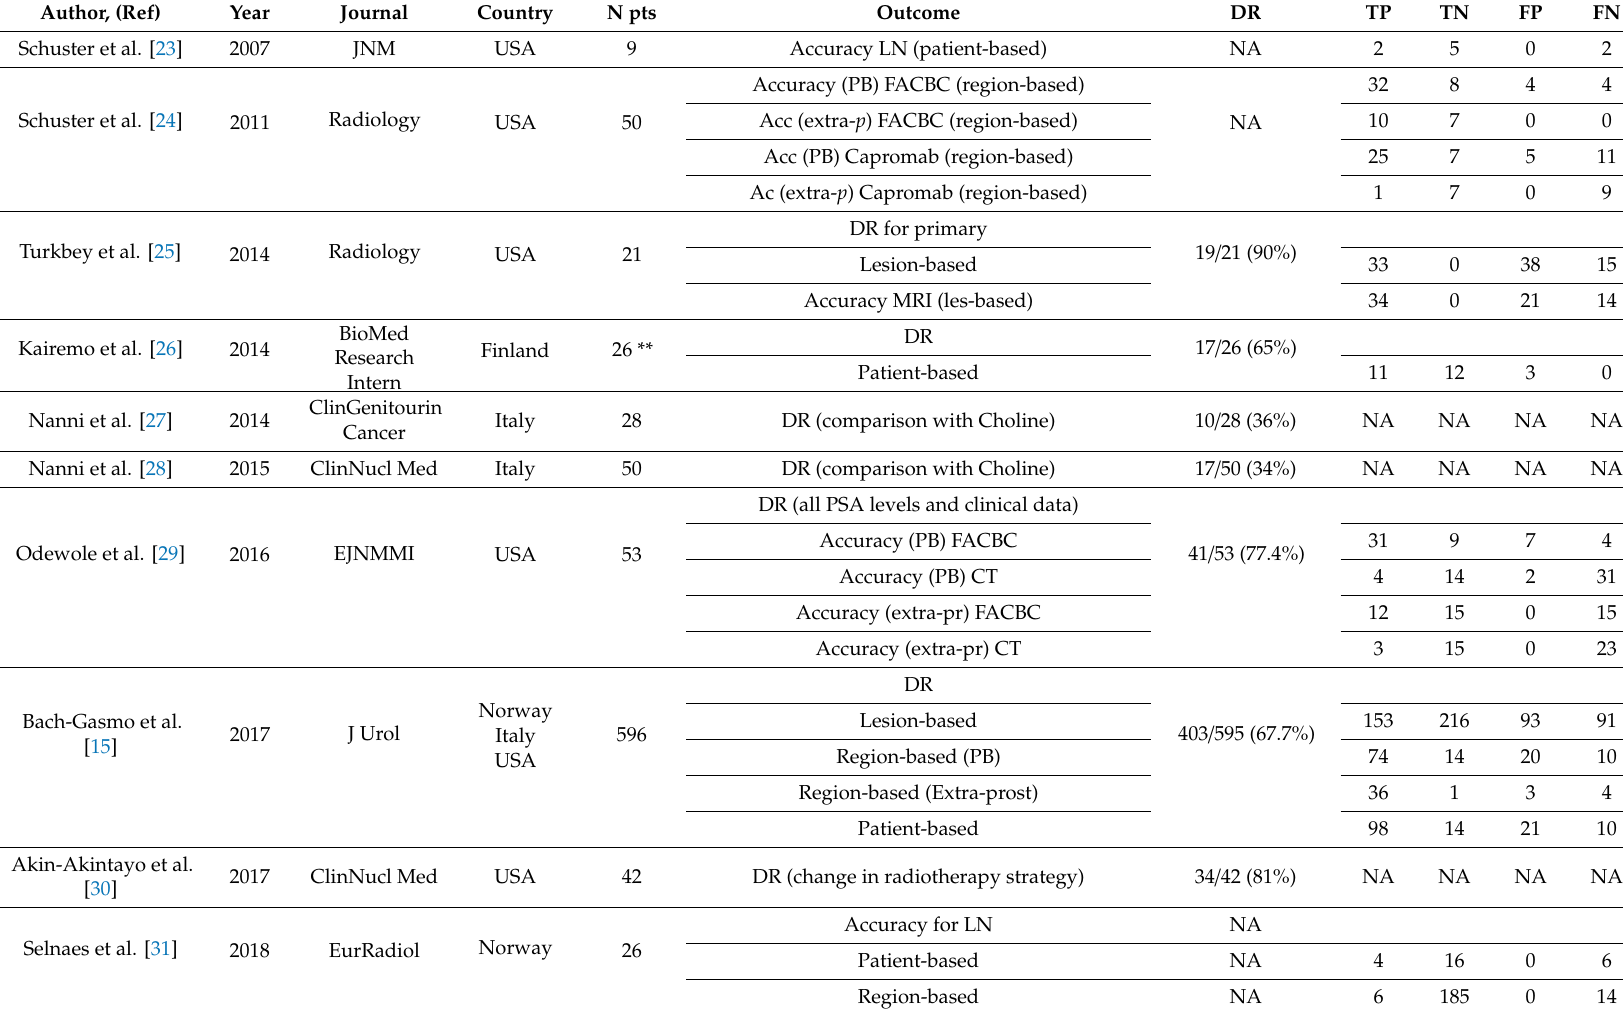
Table 2. The selection of the